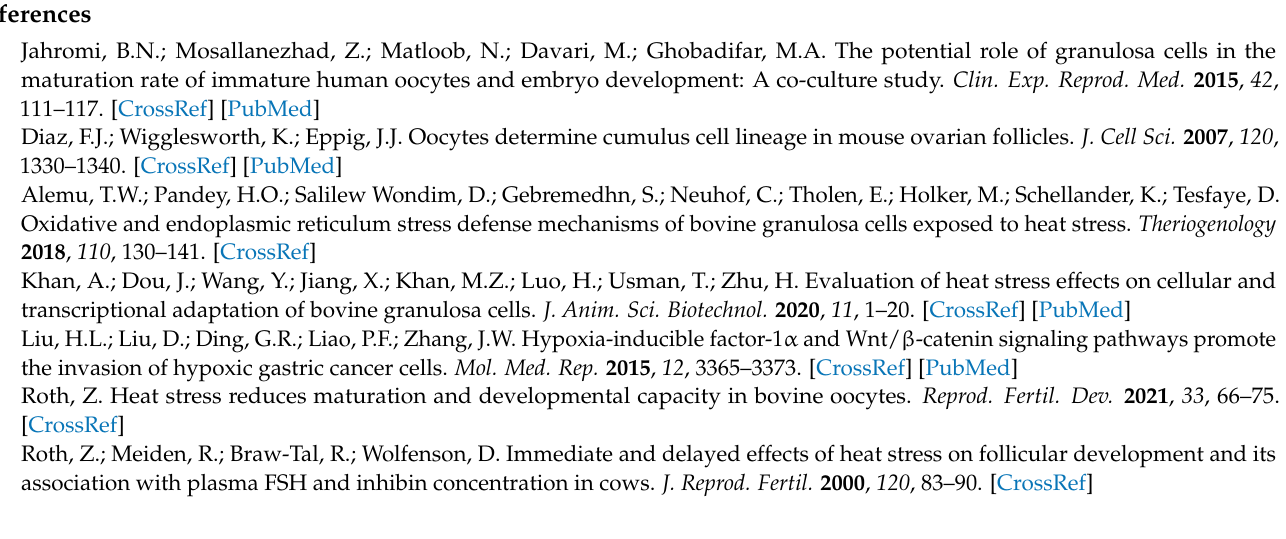
Table S6: Statistical details of three types of interactive network analyses, i.e., metabolite–metabolite interaction, metabolite–gene interaction, and metabolite–gene–disease interaction